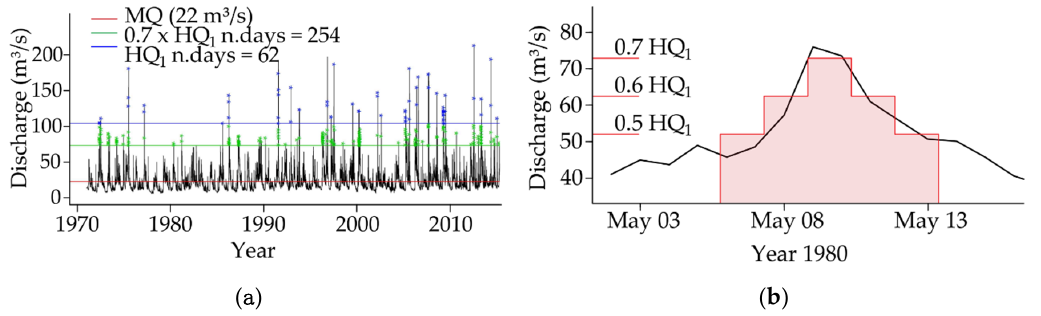
Figure 2. Hydrograph of the gauging station Kapfenberg-Diemlach in the Muerz River in Styria, Austria: ( a ) average daily flow rate for the years 1971–2015; ( b ) isolated flow event at the station Kapfenberg-Diemlach in May 1980, with a duration of 7.5 days, approximated flow event in steps of 0.5–0.6–0.7 − 0.6–0.5 × HQ 1 . Hydrograph data retrieved from www.ehyd.gv.at on 10 March 2019.